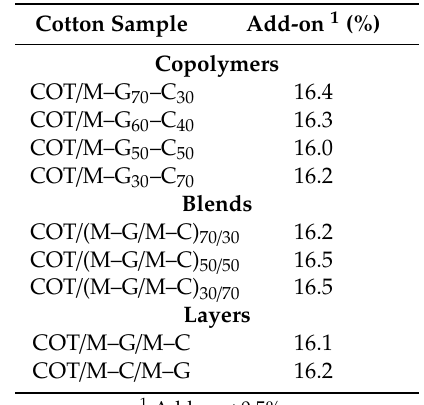
Table 2. Add-ons assessed for PAA-treated cotton